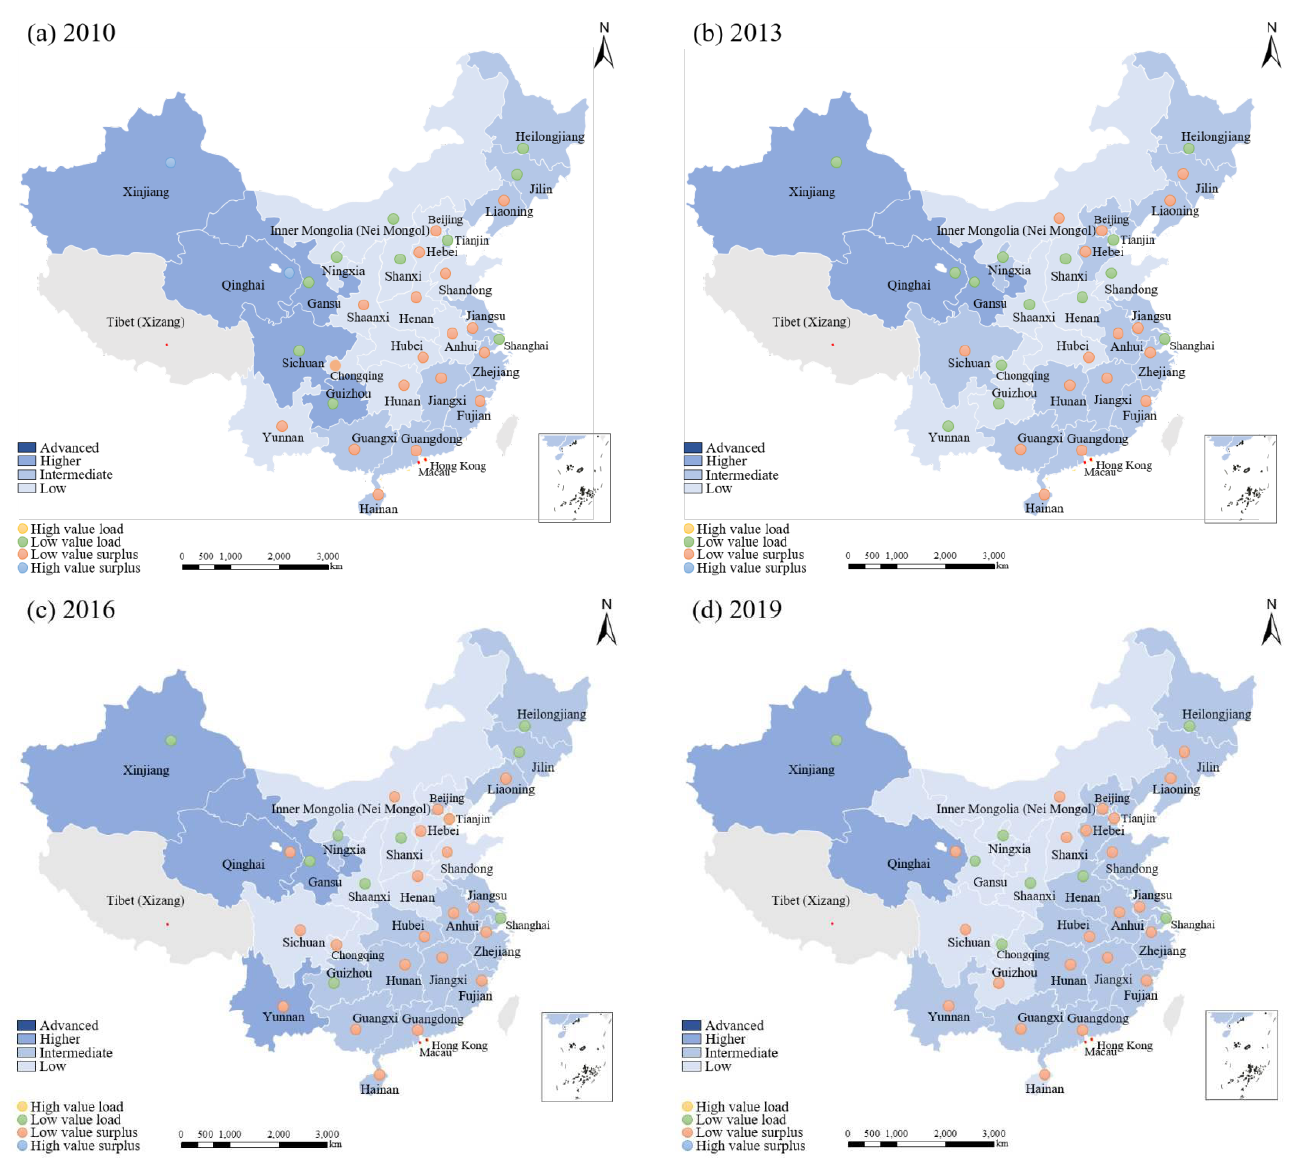
Figure 3. WRECC indicator map of China’s provinces in 2010, 2013, 2016 , and